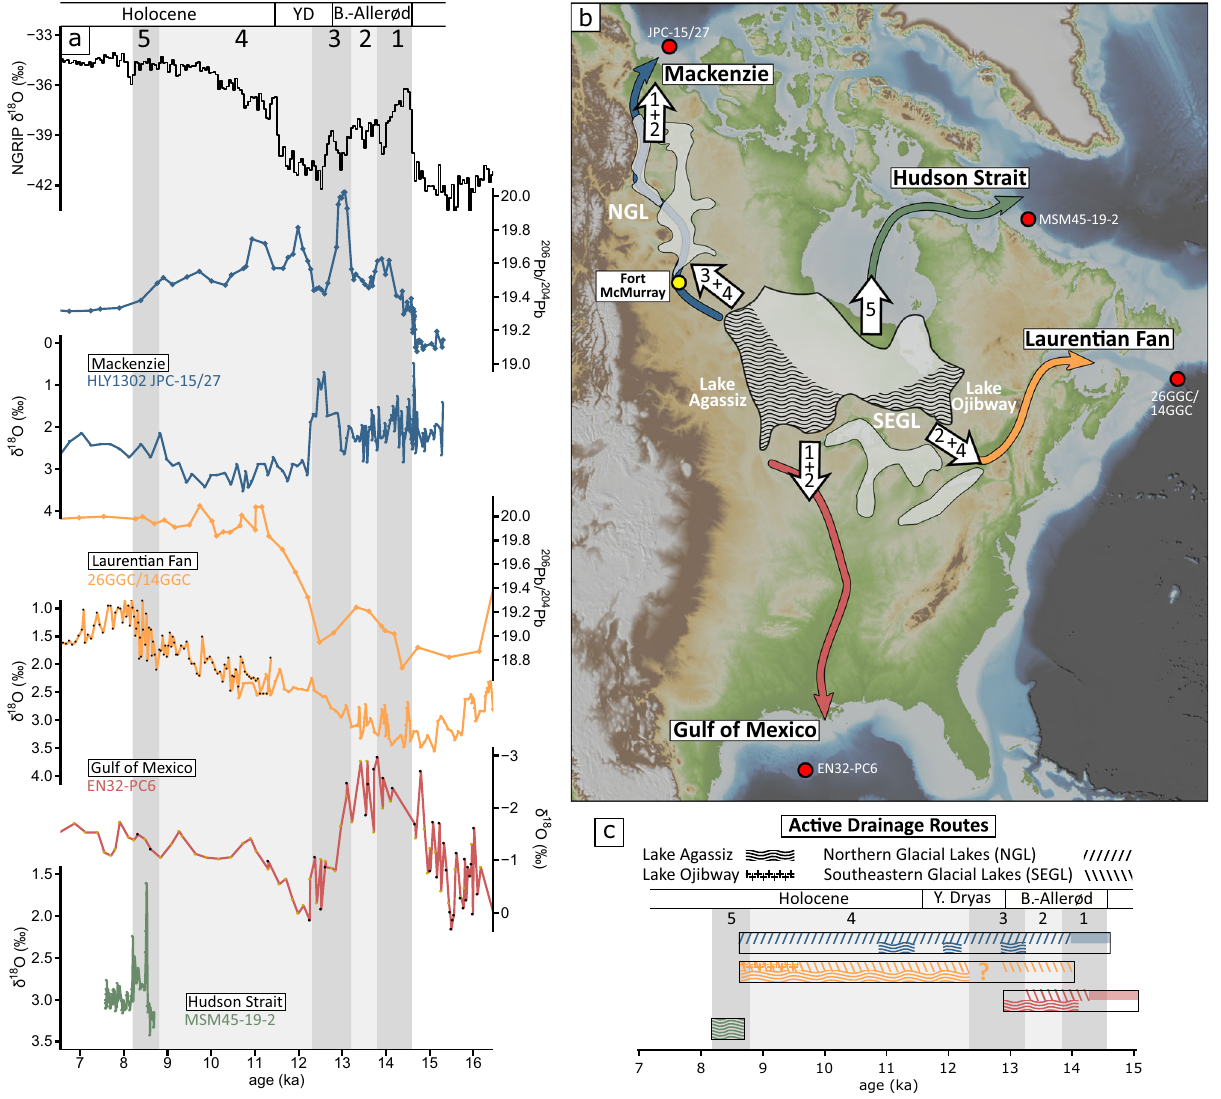
Fig. 5 Chronology of active drainage routes of meltwater from the Laurentide Ice Sheet during the Deglaciation and early Holocene. a Pb isotope ( 206 Pb/ 204 Pb) data of this study are compared to δ 18 O 6 of the same core (JPC-15/27) as well as 206 Pb/ 204 Pb 25 data planktonic δ 18 O 24 from the Laurentian Fan (composite core: 26GGC/14GGC), δ 18 O from the Gulf of Mexico (EN32-PC6; brown 3 , black 4 ), δ 18 O from the Labrador Sea as an indicator for Hudson Strait freshwaters (MSM45-19-2 47 ) and NGRIP δ 18 O 69 . b Colored arrows mark the main drainage routes. Numbers displayed in white arrows correspond to phases of different drainage route activation independent from prominent climate periods. The pale gray area depicts the area Lake Agassiz- Ojibway have occupied in the course of the Deglacial and early Holocene melting history. Wavy areas correspond to the main areas of Lake Agassiz and Lake Ojibway during the Bølling-Allerød and Younger Dryas before merging 19 . c Chart displays the major active drainage routes and their potential freshwater source. Northern glacial lakes (NGL) are Lake Mackenzie and Lake McConnell; Southeastern Glacial Lakes (SEGL) represent former glacial lakes in the Great Lakes area as well as glacial Lake